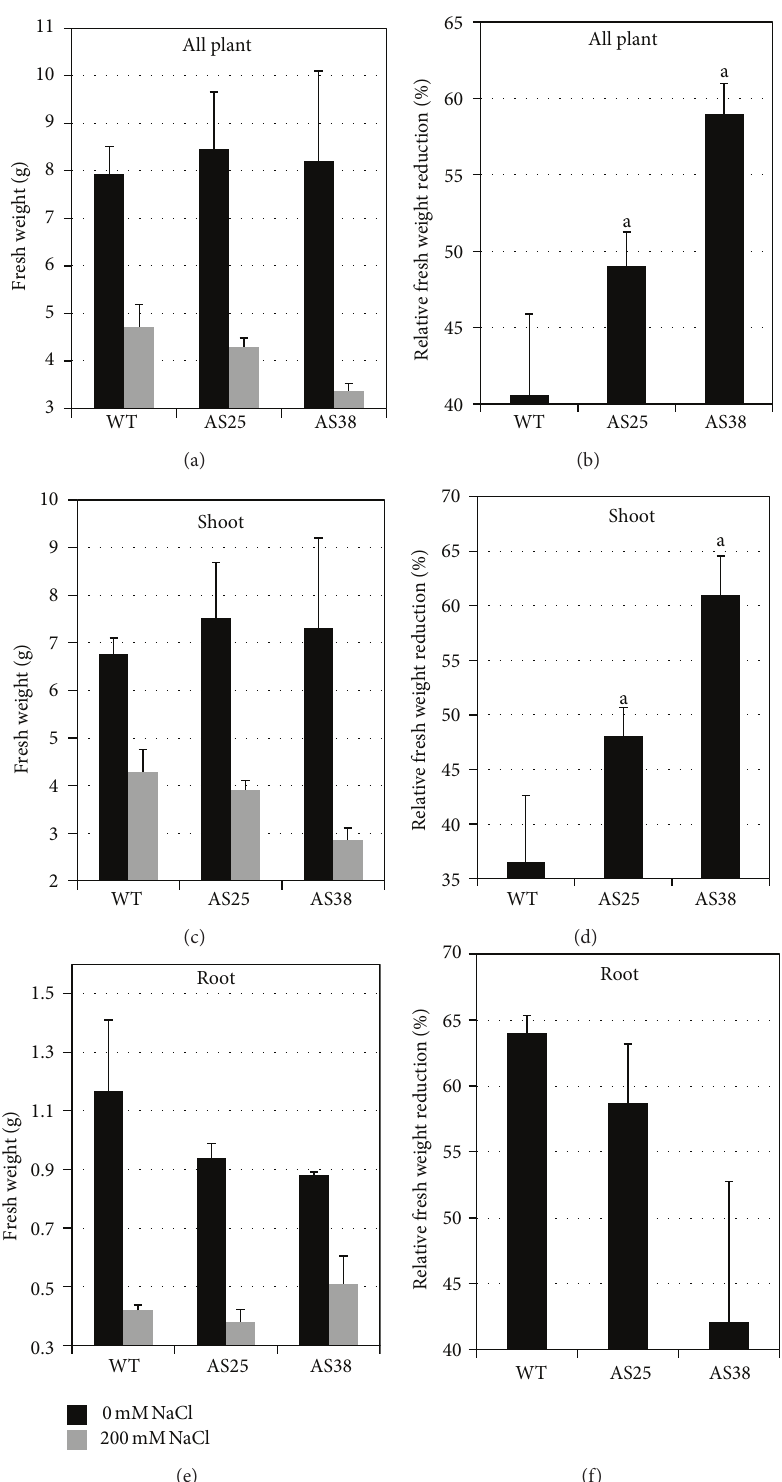
Figure 4: Salt stress effect on fresh biomass accumulation of Sl-ERF.B.3 antisense transgenic lines (AS25 and AS38) and wild type (WT) tomato plants. Variation of fresh weight means under salt treatment (200 mM NaCl) and in control conditions (0mM NaCl), in whole plants (a), in shoots (c), and in roots (e). Salt stress effect on relative fresh weight reduction is assessed in whole plants (b), in shoots (d), and in roots (f). Pairwise comparisons were made between wild type and transgenic plants with Student’s 𝑡 -test (a: 𝑃 < 0.05 , b: 𝑃 < 0.01 ). Data represent means and standard error of three